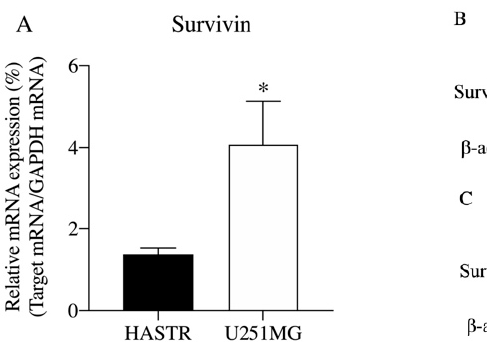
Figure 5. The e ff ects of ceramide on cell viability and caspase-3 / 7 activity in U251MG cells. Cells were pre-incubated with various concentrations of ceramide for 12 h, and then the cell number and caspase-3 / 7 activity were measured. The results are given as a percentage of the findings in the vehicle control (DMSO). Each column represents the mean ± SD ( n = 4). ** p < 0.01 compared to the vehicle control (DMSO).